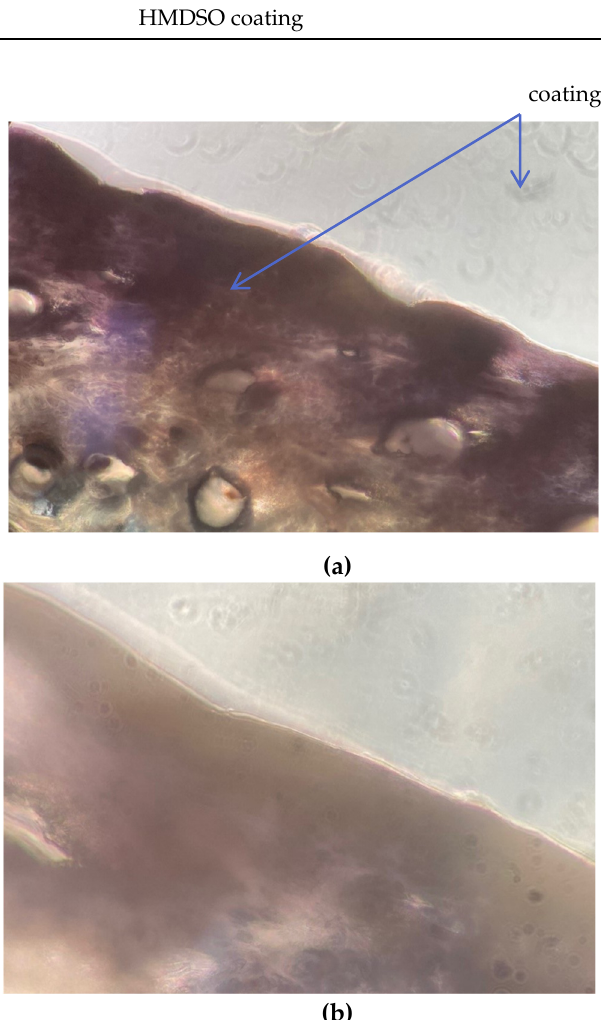
Figure 8. Cross-section images of plasma coated leather of HMDSO at 16x (a) and magnified at 40x (b).